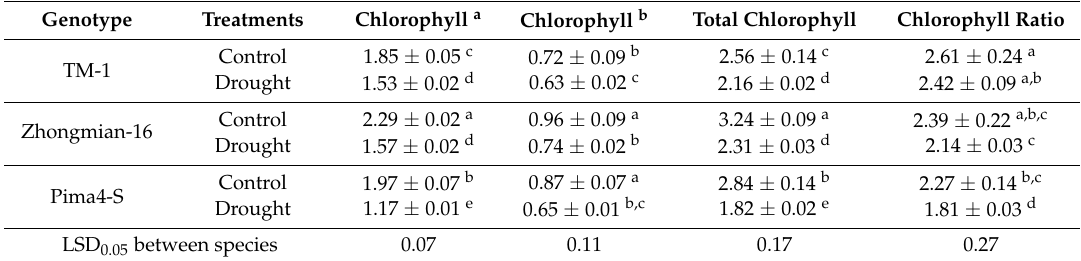
Table 2. Effect of drought stress on chlorophyll contents.